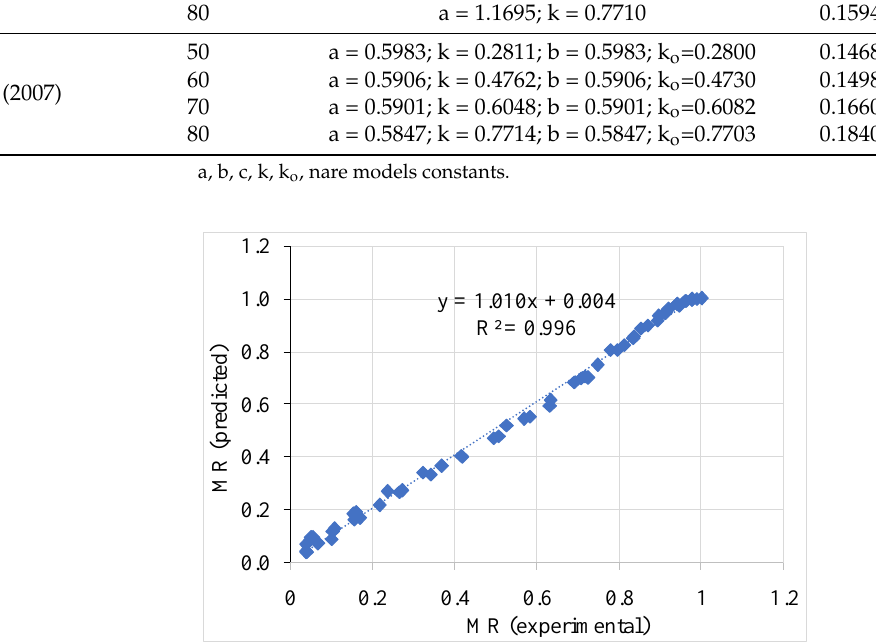
Figure 6. Correlation between the experimentally determined MR values and the MR values predicted for magenta leaves powder using Page model.